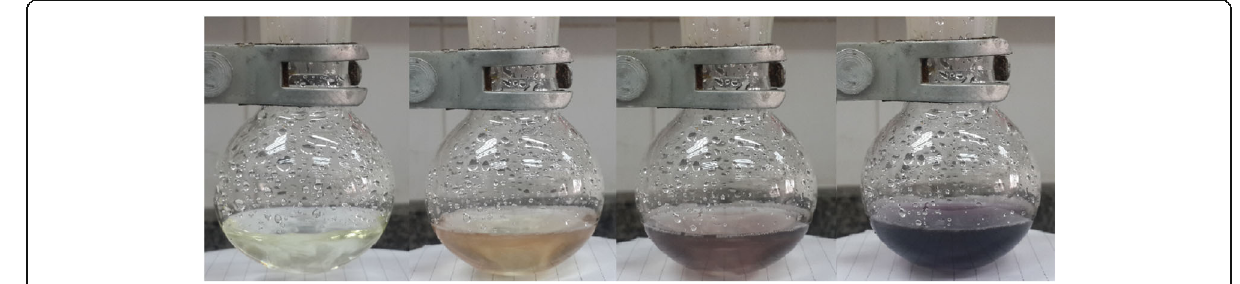
Fig. 2 Color change of solutions in AuNPs formation